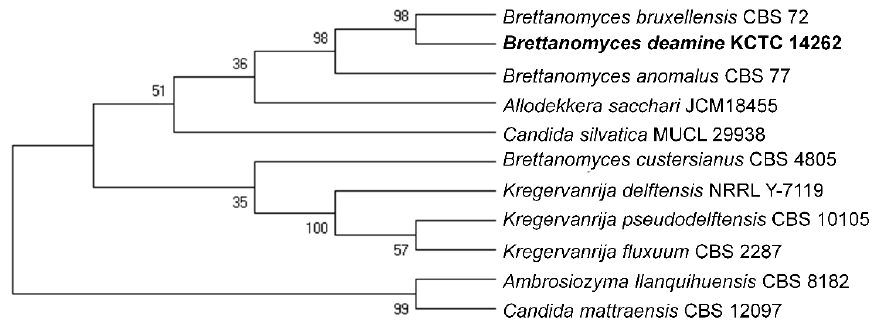
Figure 3. Statistical method of neighbor-joining tree, based on the ITS region sequences of Brettano- myces deamine kh3 (bold letter) ; Rooted neighbor-joining tree, based on the ITS region sequences, shows the phylogenetic position of the yeast strain, B. deamine kh3, and the other closest yeast genus, Brettanomyces , as well as some other related taxa.